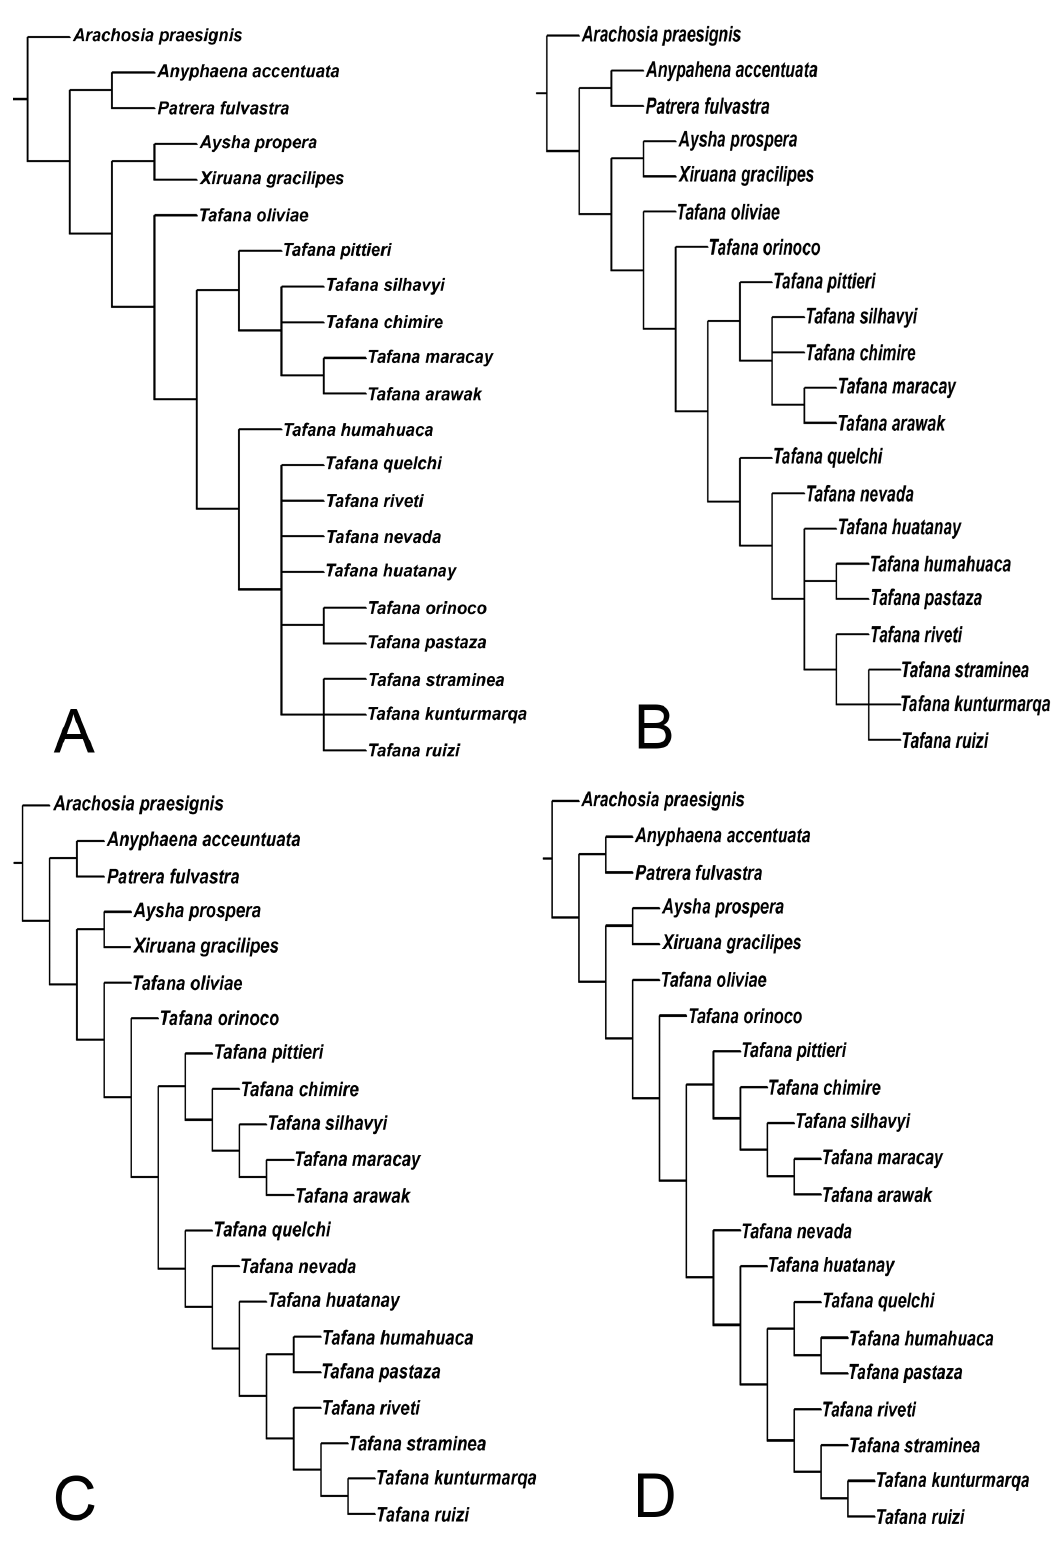
Fig. 2. Strict consensus of the most parsimonious trees obtained under implied weighting. A . Under k = 1 (CI = 0.45, R = 0.57). B . k = 2–4 (CI = 0.46, RI = 0.60). C . k = 5–10 (CI = 0.46, RI = 0.60). D . Under k = 15–100 (CI = 0.47, IR =